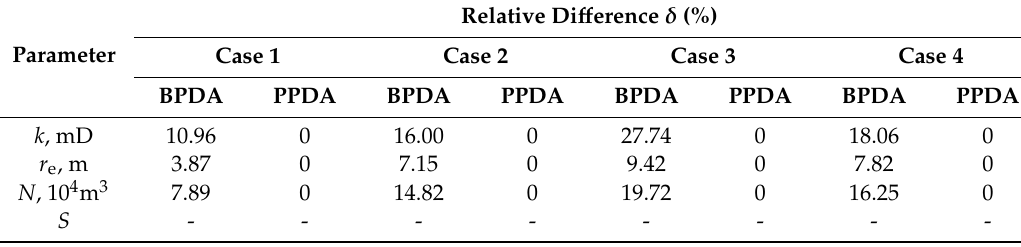
Table 11. Relative differences between the actual values and estimated values for variable- rate/pressure cases.